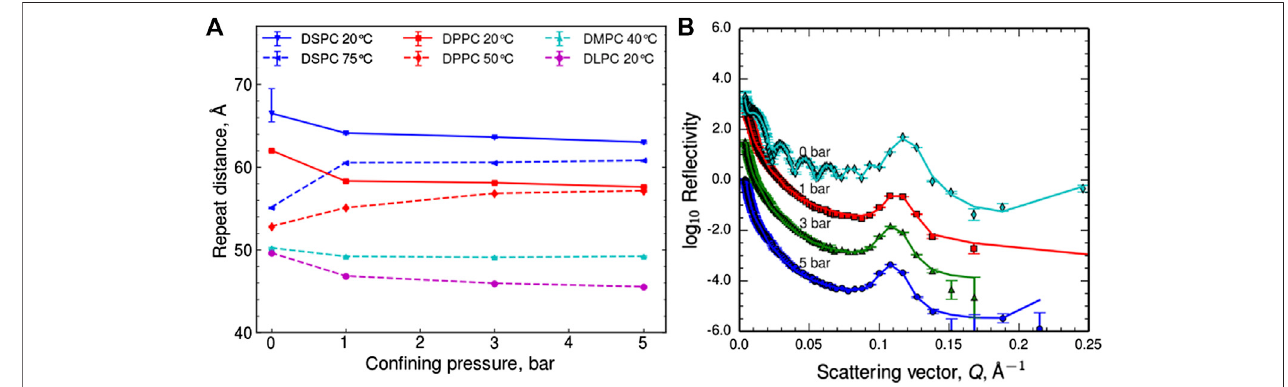
FIGURE 1 | (A) Trends of the repeat distances in the lipid bilayer stacks, hydrated with D 2 O vapor taken from the positions of the Bragg peaks. Lines are to guide the eye only, with solid lines for temperatures below the expected phase transition to L α and dashed lines for those above. (B) Neutron re fl ectometry pro fi les for DPPC